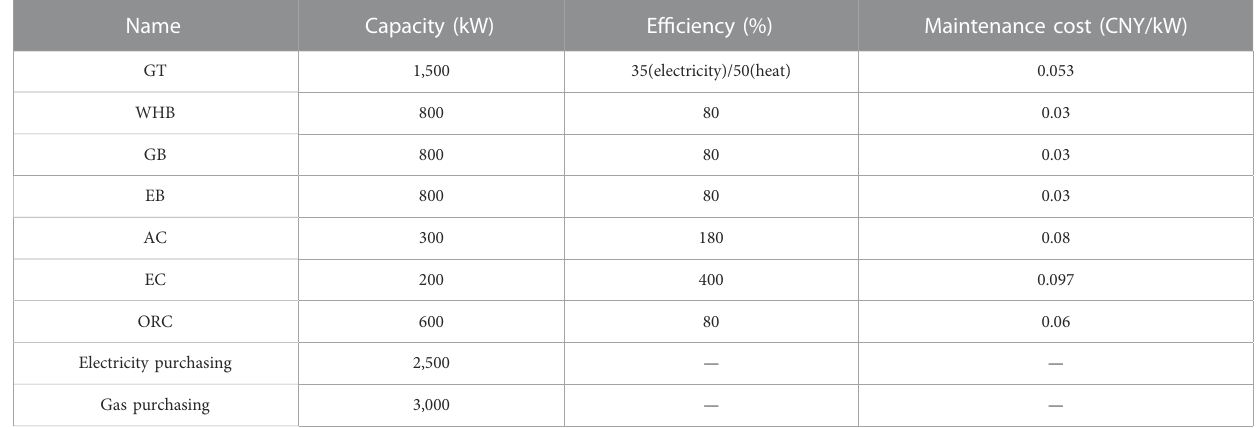
TABLE 1 Parameters of equipment.